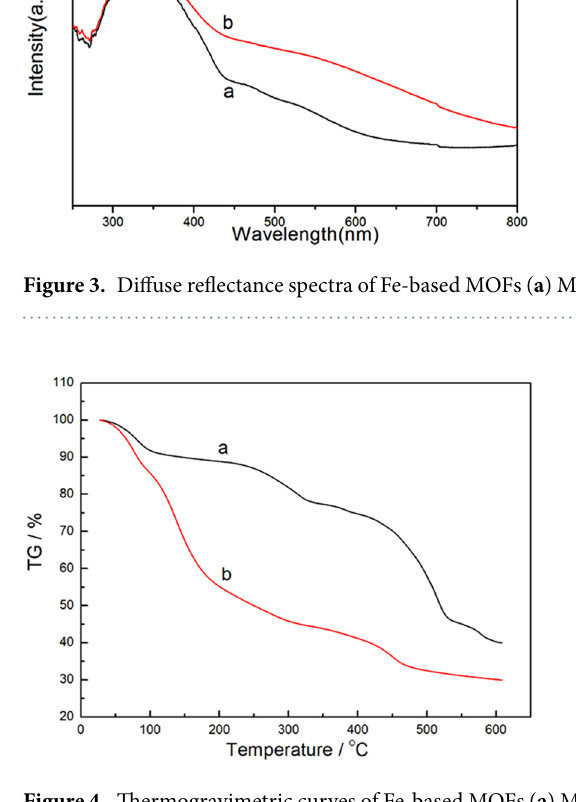
Figure 4. Thermogravimetric curves of Fe-based MOFs ( a ) MIL-101(Fe) and ( b ) NH 2